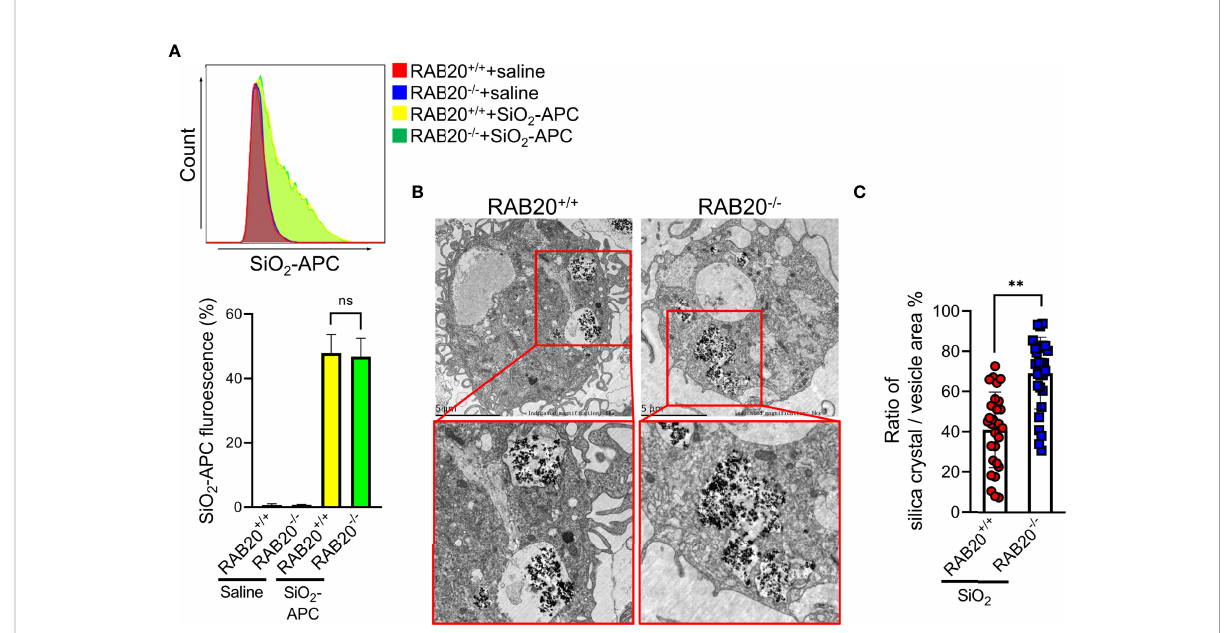
FIGURE 6 RAB20 knockout reduces the ratio of silica crystal/phagosomal area. (A) The Alexa Fluor 594 fl uorescence intensity of wild type and RAB20 knockout mouse peritoneal macrophages stimulated with Alexa Fluor 594-binding SiO 2 after LPS priming. (B) Representative TEM images of wild type and RAB20 knockout mouse peritoneal macrophages stimulated with SiO 2 after LPS priming. (C) The statistical data of the ratio of silica crystal/phagocytic vesicle area in wild type and RAB20 knockout mouse peritoneal macrophages stimulated with SiO 2 after LPS priming. **p < 0.01; no statistical difference (unpaired/two-tailed t test, one-way and two-way ANOVA test). Data are shown as mean ± SEM from three independent experiments. Scale bar represents 5 m